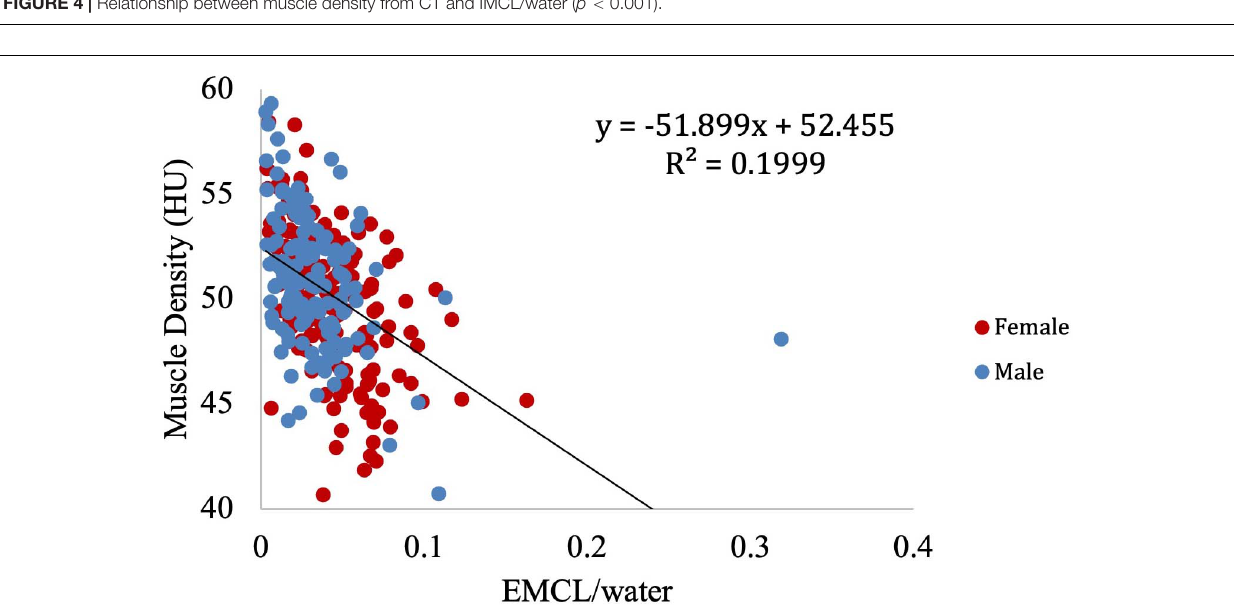
FIGURE 4 | Relationship between muscle density from CT and IMCL/water ( p < 0.001).